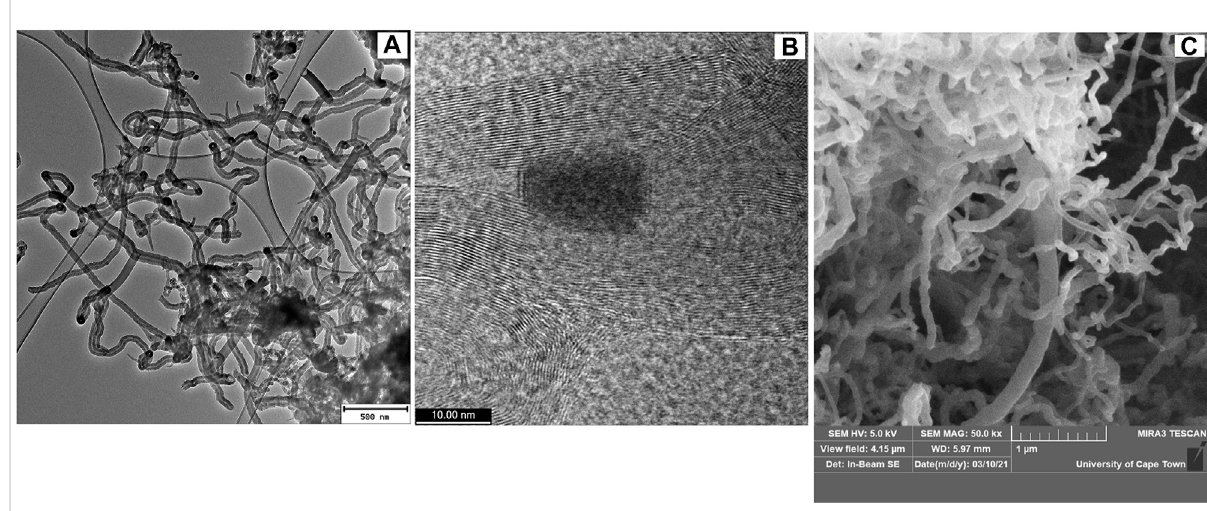
FIGURE 3 (A) TEM image of puri fi ed-CNTs generated from dichlorobenzene as the chlorine source, under the following reaction conditions: T = 700 ° C, N